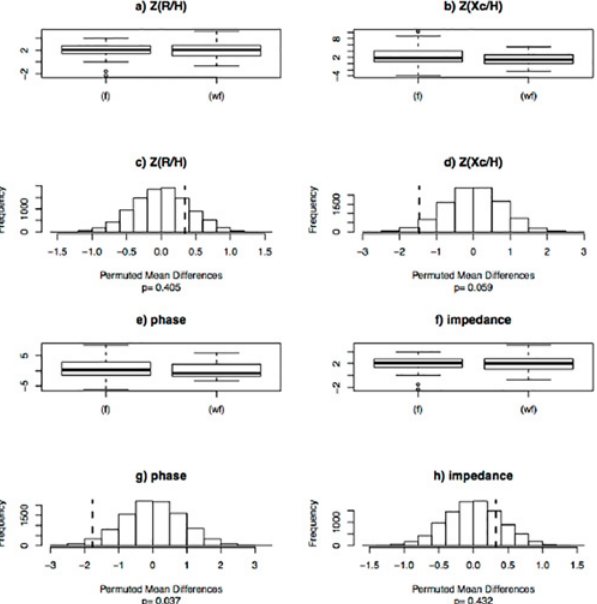
Fig 2. Permutation tests for the subjects with (f) or without (wf) fever. Sex and age observed standardized resistance, Z(R/H), and reactance, Z(Xc/H), box plots ( panels a, b ) and frequency distribution of permuted mean differences ( panels c, d ). Sex and age observed standardized phase and impedance box plots ( panels e, f ) and frequency distribution of permuted mean differences ( panels g, h ). The vertical dashed lines in the frequency graphs ( panels c, d, g and h ) show the corresponding observed mean difference. P-values for the corresponding permutation tests are reported under each histogram. R: resistance (Ohm); Xc: reactance (Ohm); H: height (m); phase: phase angle of the impedance vector (degrees); impedance: length of the impedance vector (Ohm).